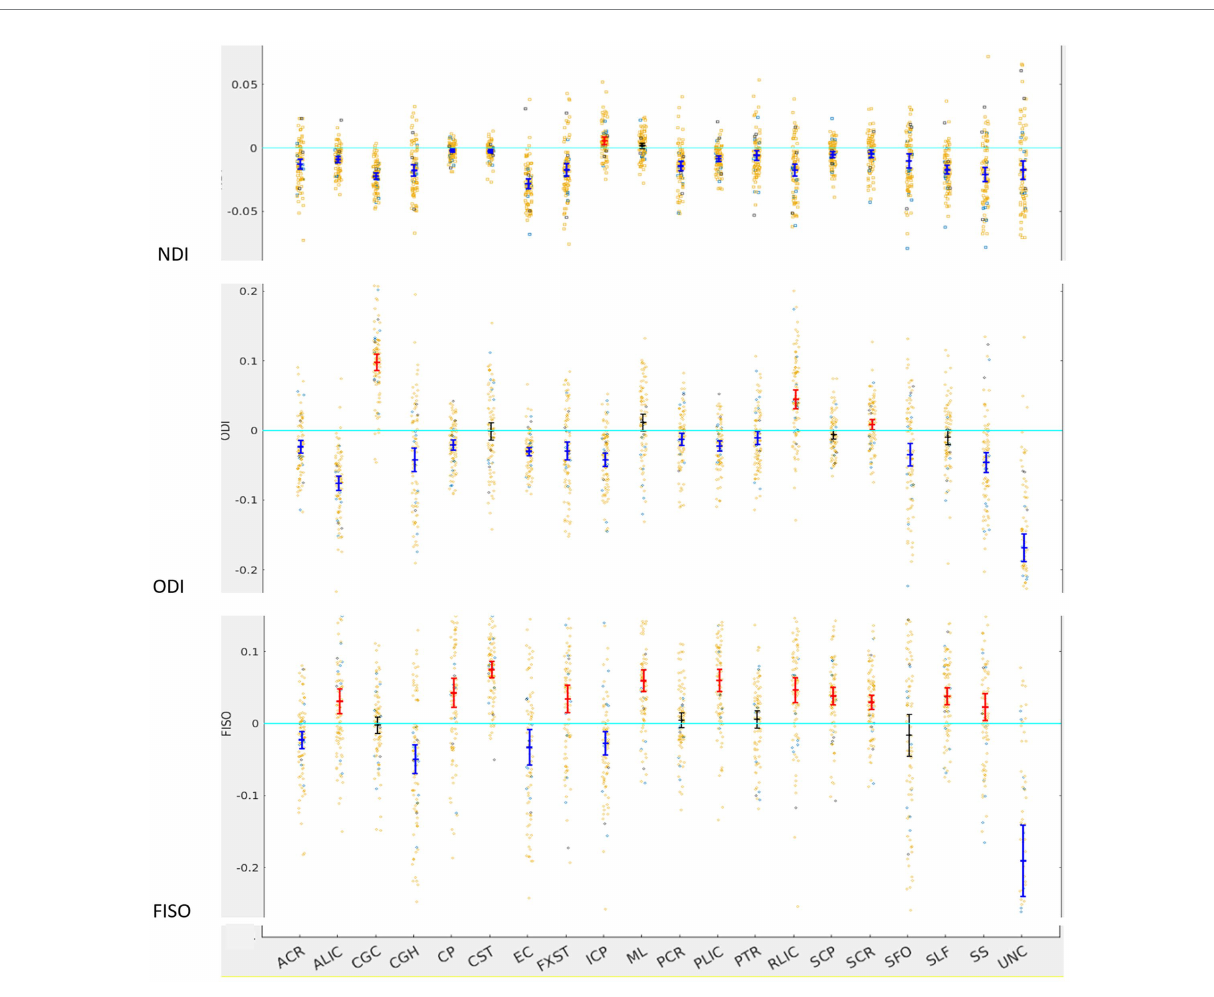
FIGURE 2 LI plotted for each of the 87 participants for the 20 bilateral tracks for DTI metrics, the mean and 95% CI are represented in the figure, 95% CI bars in red represents significant right lateralization (positive LI) of the tract while blue bar represents significant left lateralizatin (negative LI) of the tract. Yellow dots reperesent right-handed subjects (79) while blue dots represent left-handed subjects (9), subjects where handedness data was missing are plotted in black (3).